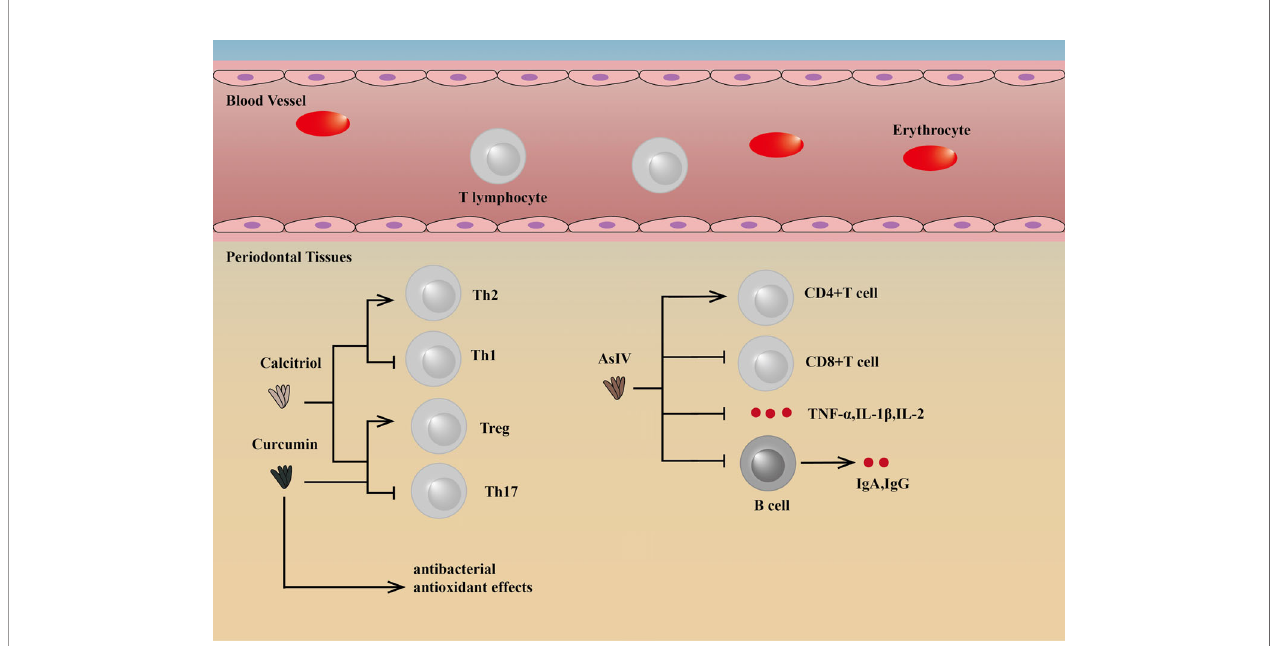
FIGURE 4 | Drugs targeting T lymphocytes and their mechanisms. Curcumin and calcitriol can regulate the differentiation of Th cells, thus playing a therapeutic role. Both of them can inhibit the loss of alveolar bone by changing the proportion and function of Th cell subsets, which is manifested by the increase of Treg cells and the decrease of Th17 cells. Calcitriol intervention can also increase Th2 polarization potential and decrease Th1 promoter (97, 98). In addition, curcumin also exerts antibacterial and antioxidanteffects (99, 100). AsIV can increase peripheral blood CD4(+)T cell percentages and the CD4(+)CD8/CD8(+) T-cell ratio, while the percentage of CD8(+) T cells can be signi fi cantly reduced, as well as TNF- a , IL-1 b , IL-2, IgA and IgG (96). AsIV, Astragaloside